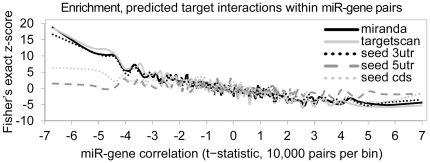
Gene transcripts with miRNA 7mer in the 3′-UTR tend to be anti-correlated with expression of the corresponding miRNA.Analogous to Figure 4A, scatter plot showing mean correlation versus significance of enrichment for predicted target interactions (enrichment expressed as a Fisher's exact z-score), when separately considering the following potential interactions: 7mer seed sequence in 3′-UTR (black dotted line), 7mer seed sequence in 5′-UTR (black dashed line), 7mer seed sequence in coding sequence region (“cds,” gray dotted line), miRanda prediction (black solid line), TargetScan prediction (gray solid line). Plot uses bins of 10000 miRNA:mRNA pairs (total number of pairs represented: 191 miRNAs X 8547 genes). Fisher's exact z-score of +/−2.57 corresponds to significant enrichment (nominal P<0.01) for predicted targets within miRNA:mRNA pairs.